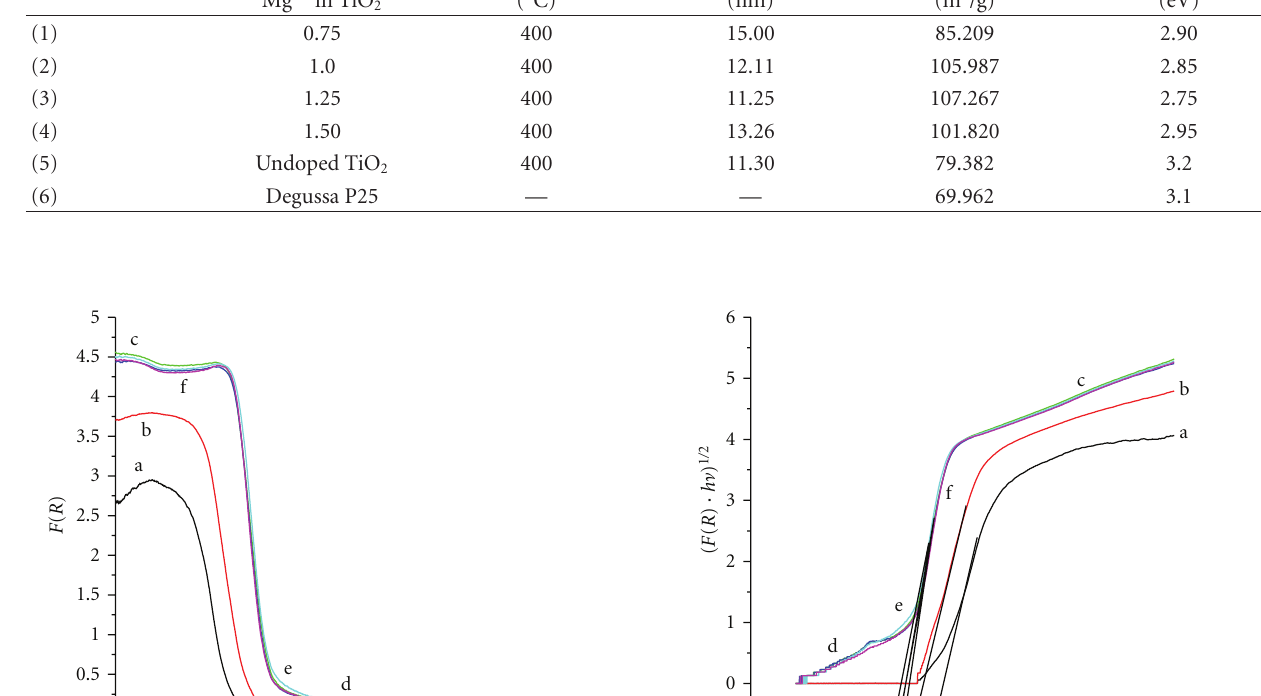
Table 1: Crystallite size, BET surface area, and bandgap energy of each catalyst. Catalyst no.